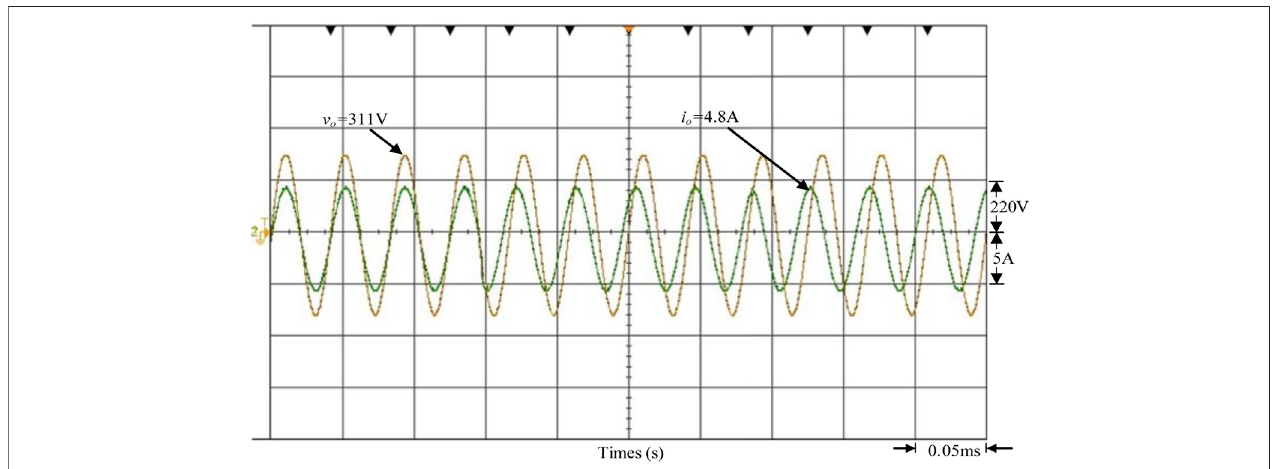
FIGURE 19 | The measured waveform of the output voltage and current of the smart inverter when the grid voltage per unit value is between 0.97 and 1.0 p.u.